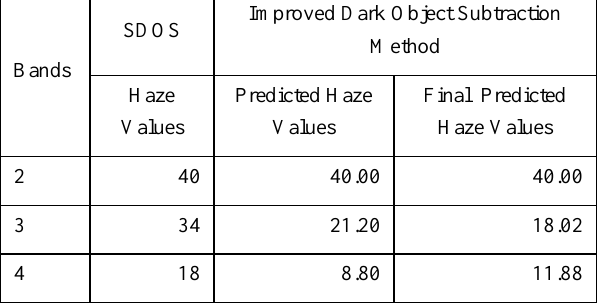
Table 8. Final Predict Haze Values of Very Clear Relative Scattering Model.